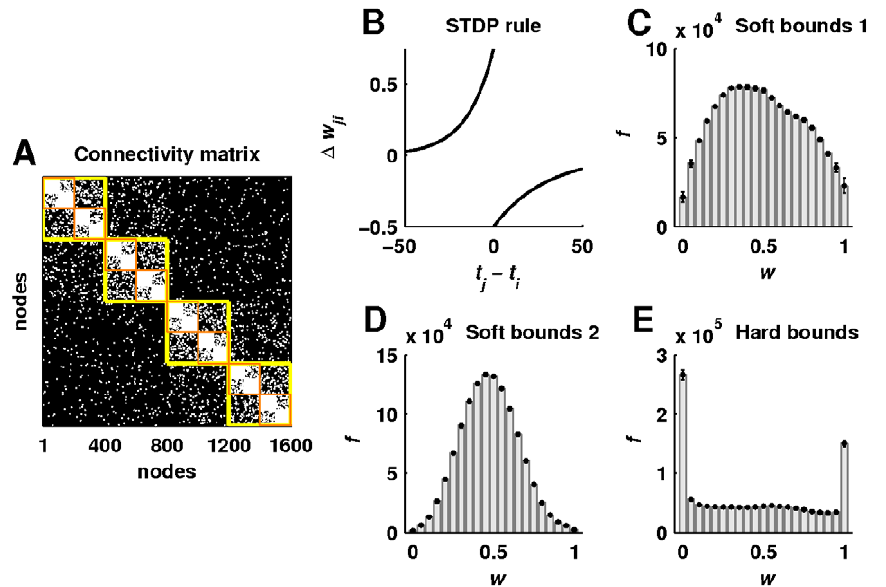
Figure 1. Hierarchically modular connectivity and spike-timing-dependent plasticity. (a) An illustrative connectivity matrix of a hierarchical modular network. This network consists of sixteen 100 -neuron modules, organized into four hierarchical levels. Squares in the connectivity matrix outline the nesting of hierarchical level 1 (small orange squares) inside hierarchical level 2 (large yellow squares). In the present study we considered networks of 7 hierarchical levels and 12800 neurons. (b) An illustration of the synaptic plasticity rule used in the study. (c) Weight frequency distributions for the STDP rule with soft bounds (used in most simulations). (d) Weight frequency distributions for the STDP rule with soft bounds and reduced learning rate (used in some simulations). (e) Weight frequency distributions for the STDP rule with hard bounds (used in some simulations). Error bars represent the standard deviation.